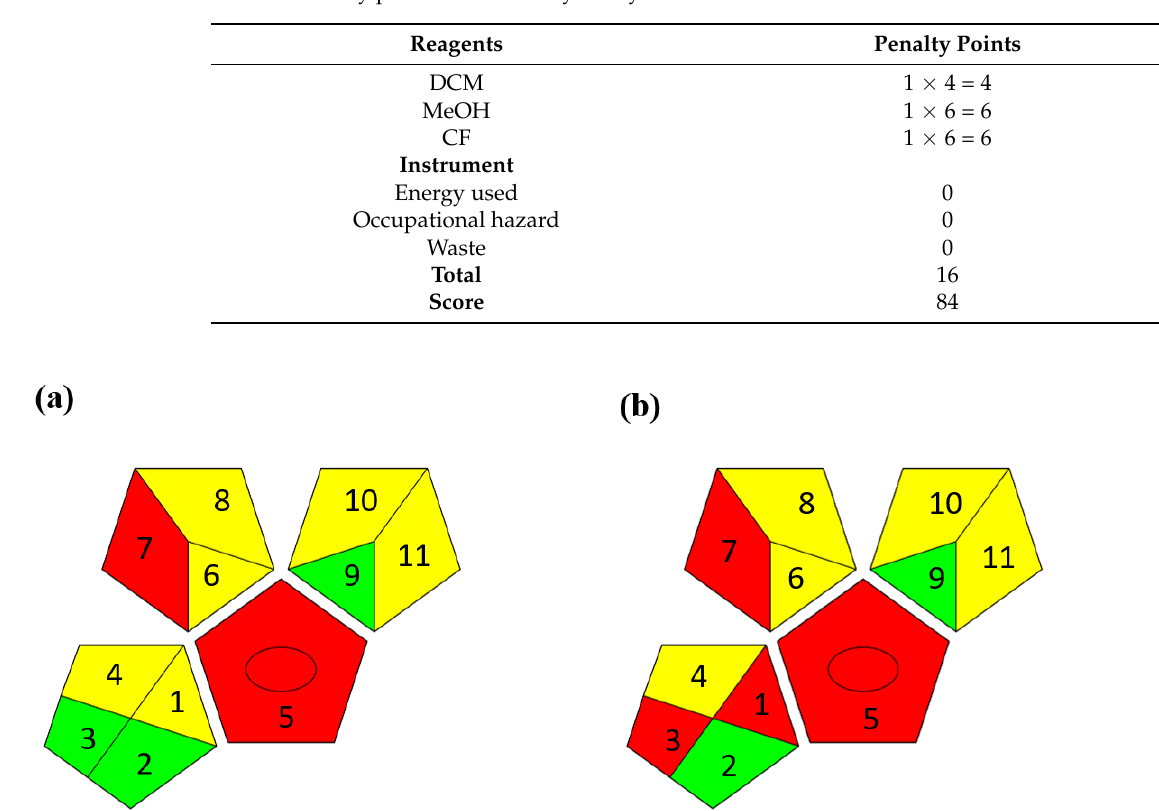
Figure 5. AGREE pictograms of the proposed method.